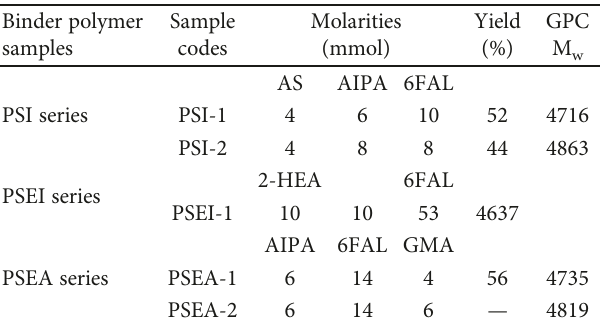
Table 1: Synthesis of side-chain polyimides for binder polymers of black photoresists. Binder